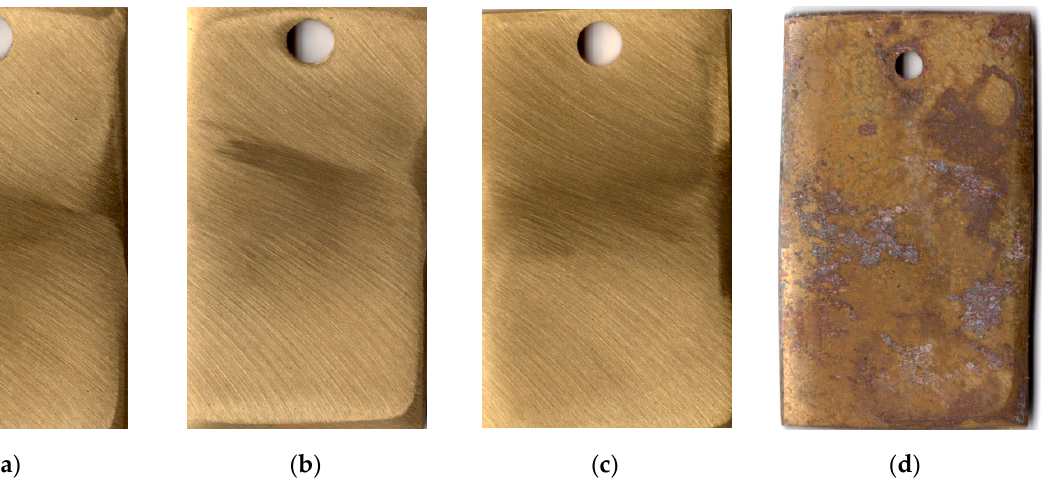
Figure 6. Brass samples after weathering tests for 25 months: chamber treatment with CIN vapors ( a – c ); without chamber treatment ( d ).